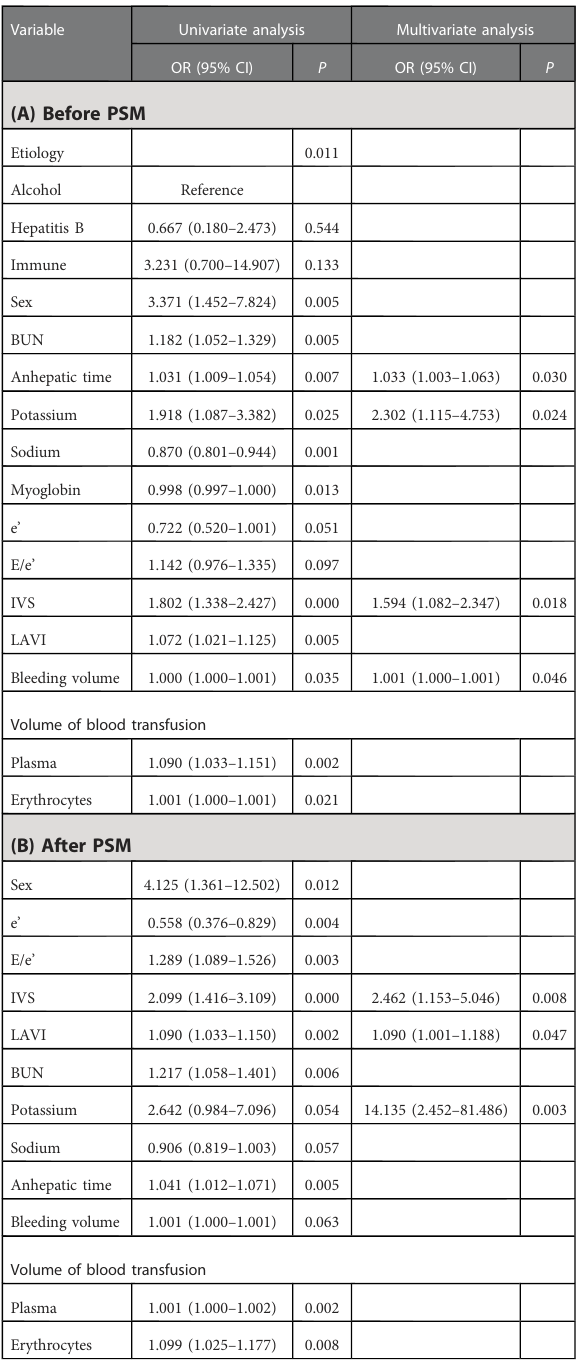
TABLE 5 Univariable and multivariable logistic regression analysis of perioperative cardiovascular adverse events.